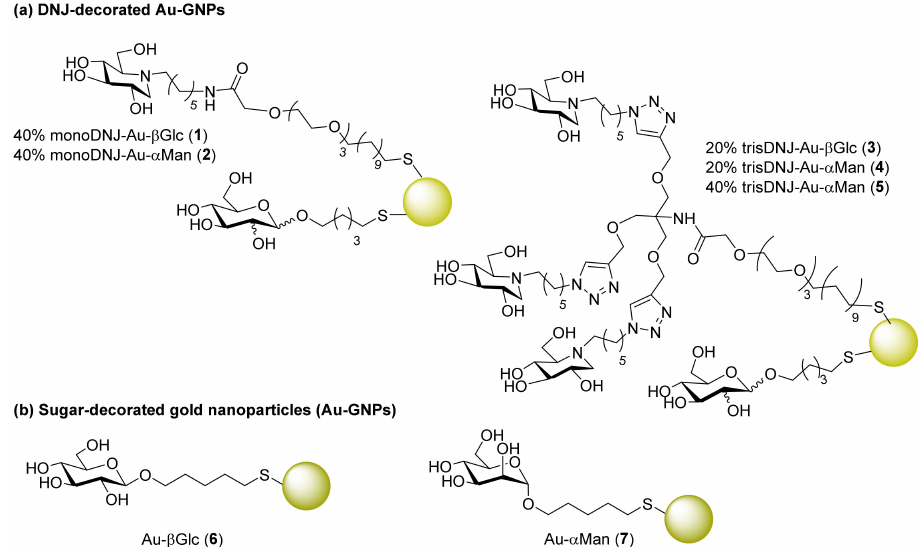
Figure 2. ( a ) Schematic representation of the multivalent glyco-gold nanoparticles coated with the iminosugar DNJ derivatives and monosaccharides ( β -D-glucose or α -D-mannose